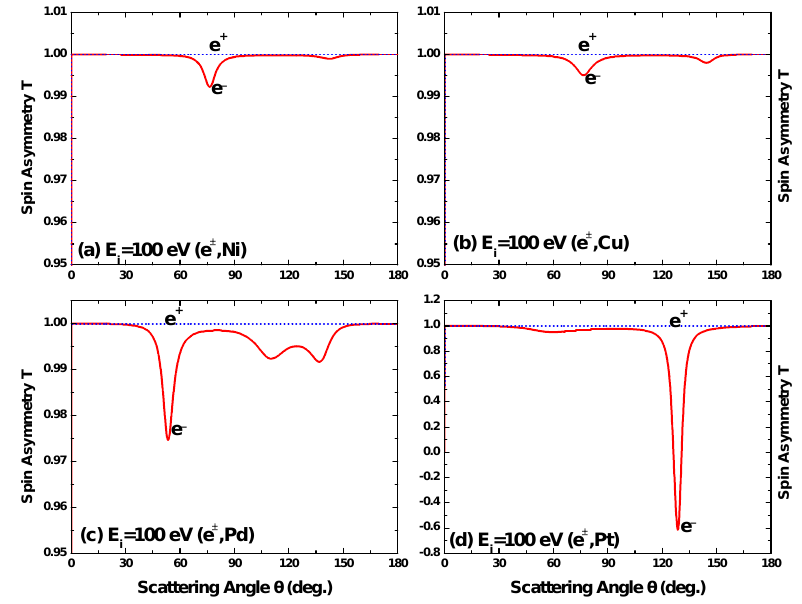
Figure 29. Angular variation of the spin asymmetry parameter T for e ± impact scattering from ( a ) Ni 58 , ( b ) Cu 63 , ( c ) Pd 108 , and ( d ) Pt 196 at a collision energy of 100 eV. (——-, red), electrons; ( · · · · · · , blue),